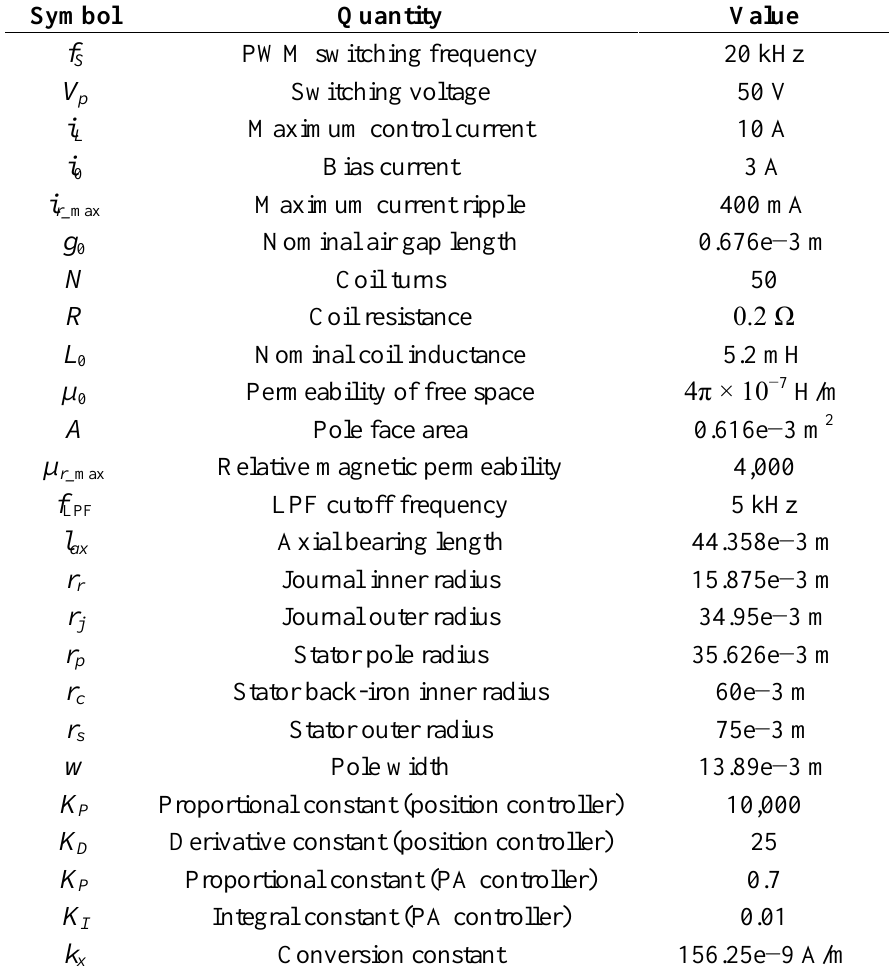
Table 1. Experimental magnetic bearing and self-sensing parameters.